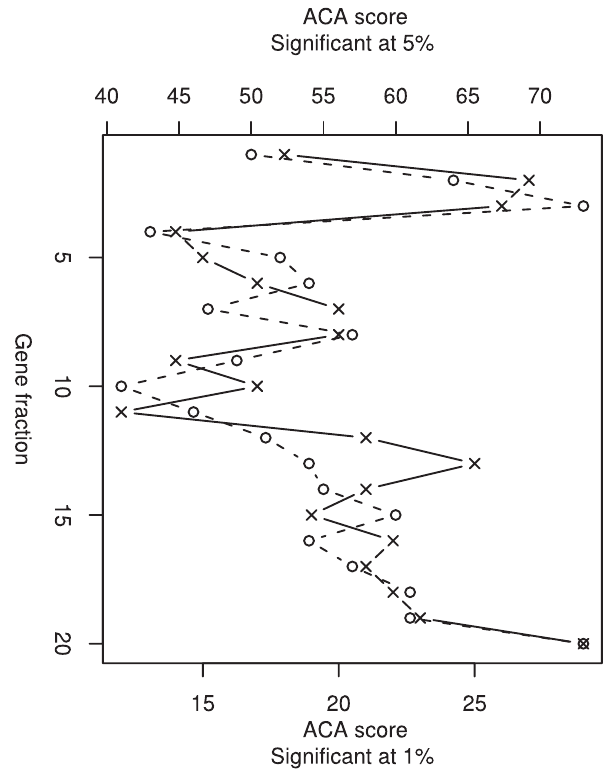
Figure 4. The positions of the mid-point of RTS clusters across genes. Each gene was split into 20 bins so that genes of different lengths can be compared. The positions of RTS clusters are determined by the gene fraction in which the cluster arises. The frequency of RTS clusters was not evenly distributed across genes, but skewed toward the 5 9 end and the 3 9 end (p , 0.001). The distribution of RTS clusters defined by p , 0.05 is shown by hollow circles, while those highly significant RTS clusters, defined by p , 0.01, are shown by